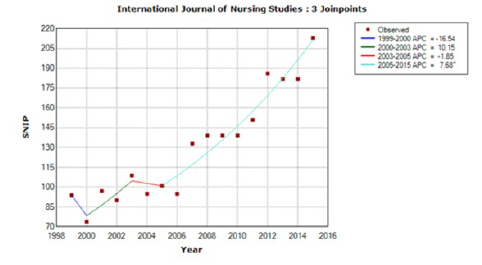
Figure 1 Trend model for the International Journal of Nursing Studies